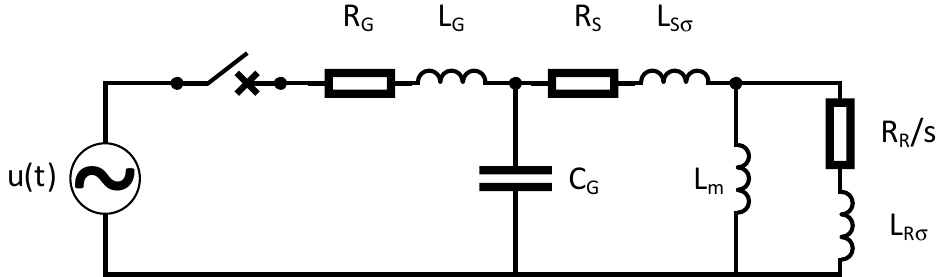
Figure 2. Equivalent circuit of an induction motor for simulating switching transients. Source: [6] and own modification.